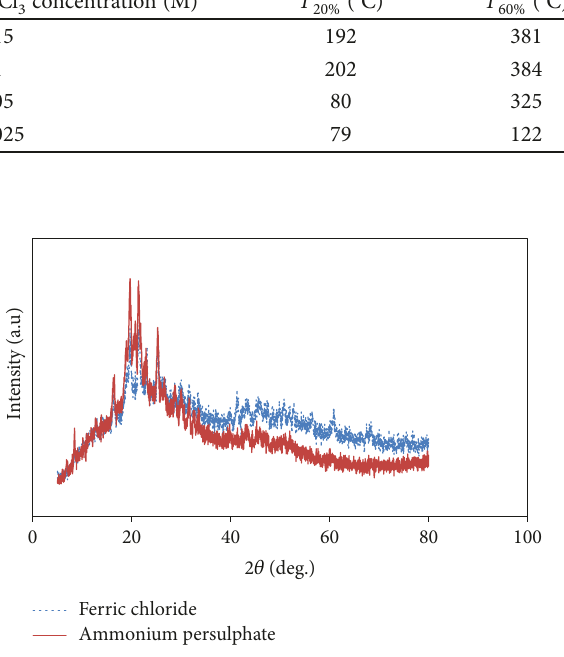
Figure 11: X-ray di ff raction of PPy samples (oxidant 0.1M, pyrrole